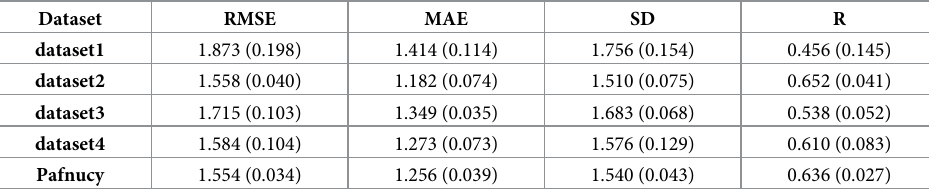
Table 6. The performance of GraphBAR with the CSAR NRC-HiQ set 2 (36 complexes).